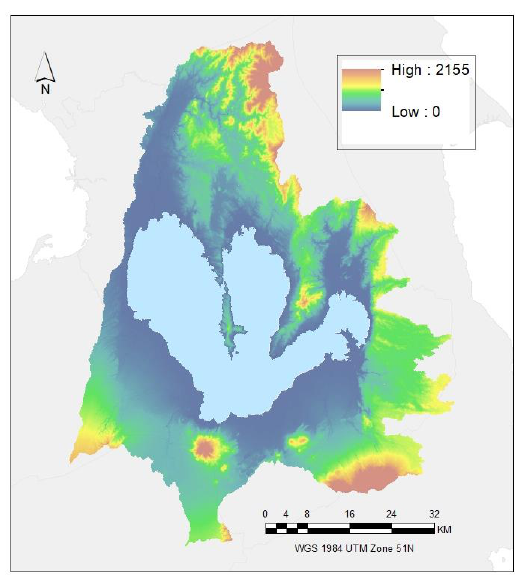
Figure 2 . Digital Elevation Model (DEM) of the study area.